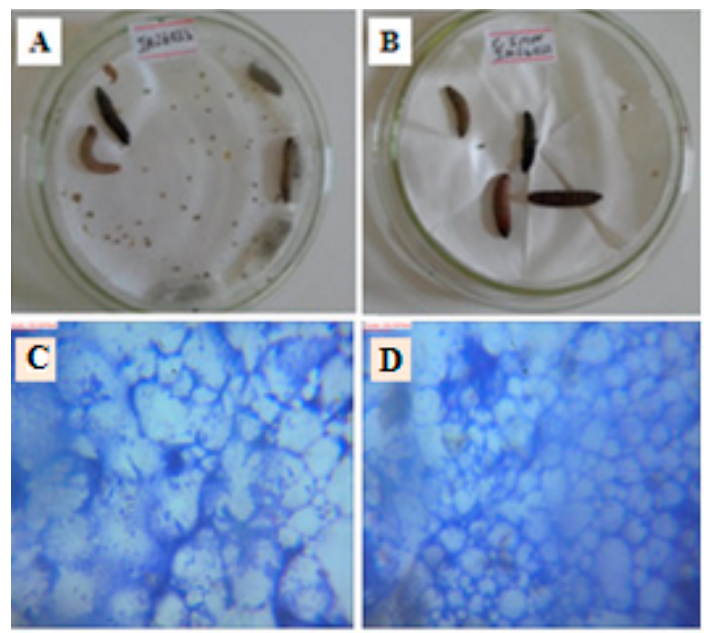
Figure 11. ( A , D ) Infected larvae (Positive control) and their appearance under the microscope at the magnification of 100×; ( B , E ) Non-infected Larvae (Negative control) and their appearance under the microscope at the magnification of 100×; ( C , F ) Larvae injected with Free CS/TPP and their appearance under the microscope at the magnification of 100×.